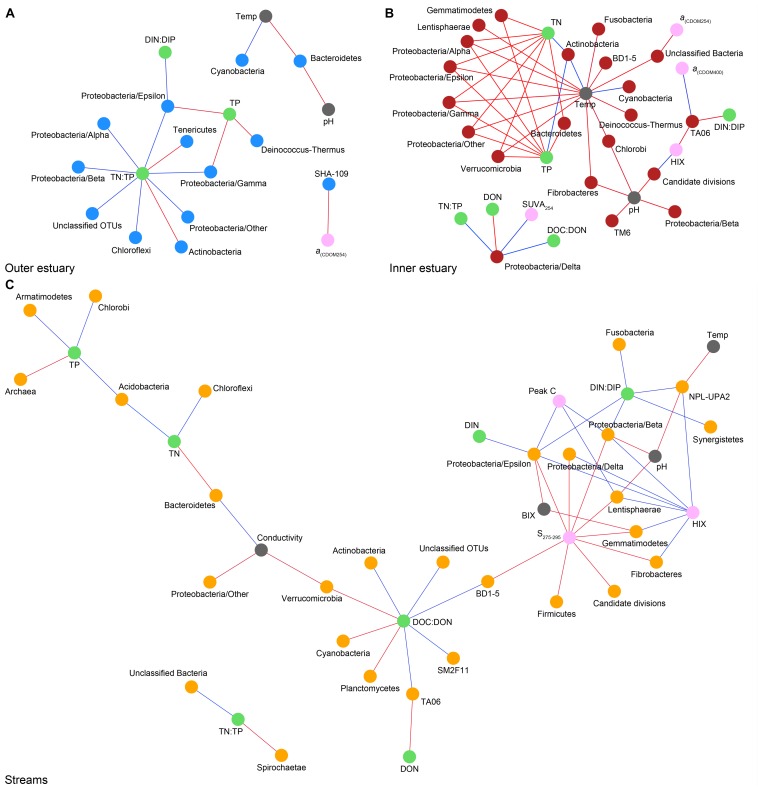
Spearman correlations (visualized as networks) between abiotic variables and phyla with statistically significant correlations (p < 0.05) and rs > 0.7 (blue lines) or < –0.7 (red lines). For the microbial phyla, blue dots show “outer estuary” (A), red dots denote the “inner estuary” (B), and yellow dots show data from the five stream sites (C). Abiotic variables are marked by gray dots, with green dots for nutrient-related variables and pink dots for CDOM and humic-like-related variables.